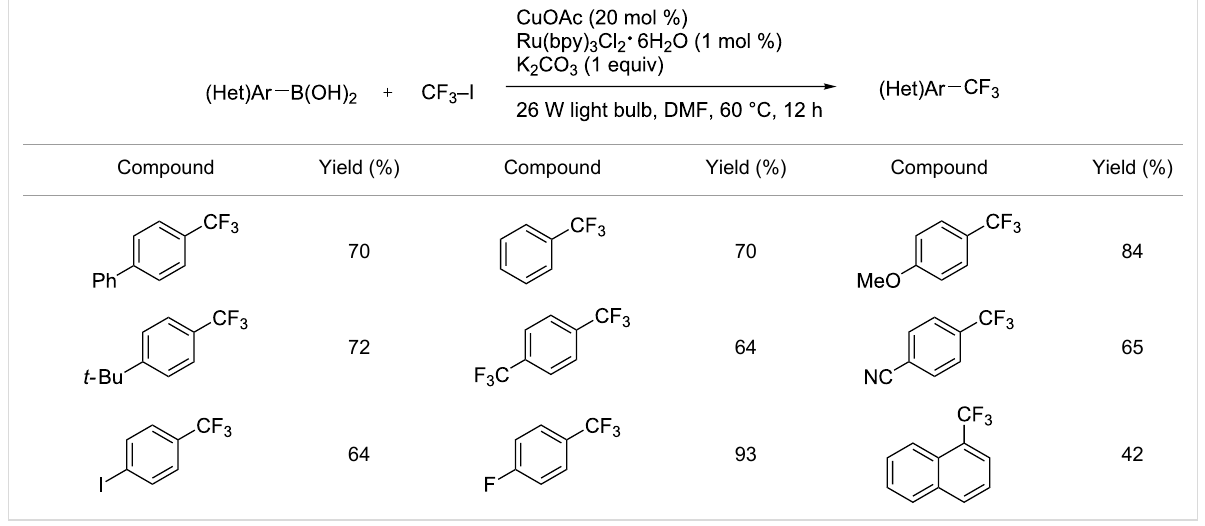
Table 26: Sanford’s Cu-catalyzed/Ru-photocatalyzed trifluoromethylation and perfluoroalkylation of (hetero)arylboronic acids [96].